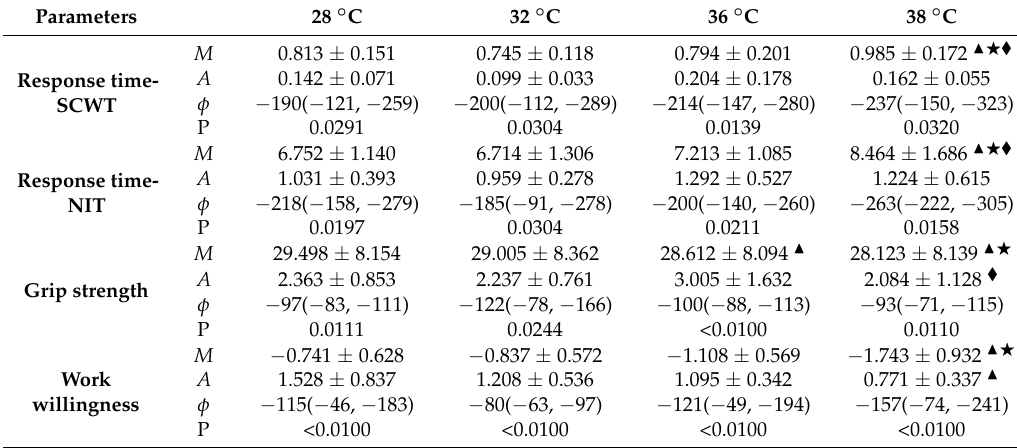
Table 3. Cosinor analysis results of circadian rhythms of subjects’ work efficiency